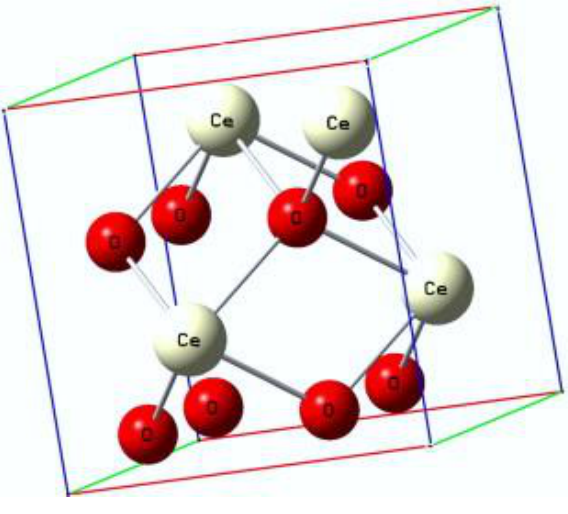
Figure 5. The FCC-CaF 2 crystallographic structure of the cerium oxide unit cell. Reproduced with permission from Ref. [33]. Copyright© 2009, Elsevier.